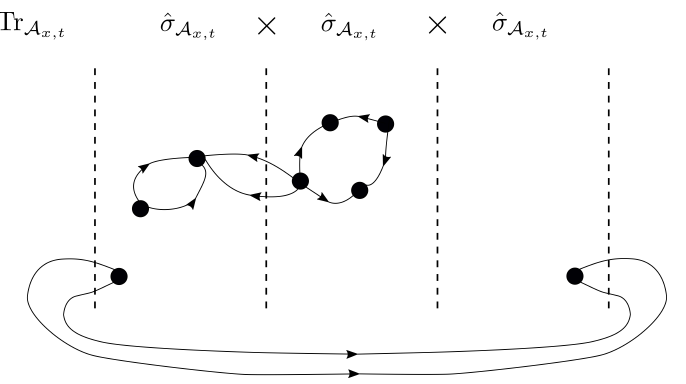
ˆ σ 3 A x , t A x , t